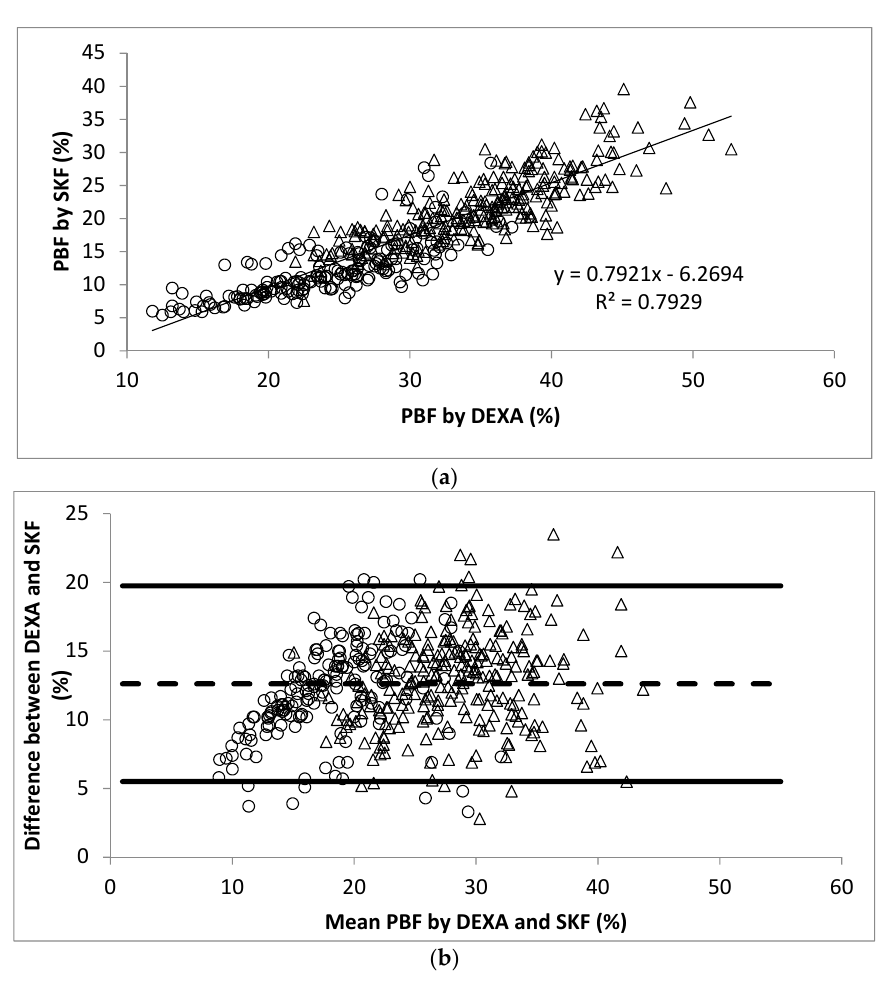
Figure 3. ( a ) Scatter plot of PBF calculated by DEXA and SKF in 445 participants. The Pearson’s correlation coefficient is 0.89; ( b ) Bland-Altman plot for data from ( a ). Men were represented by the open circles and women by the open triangles.